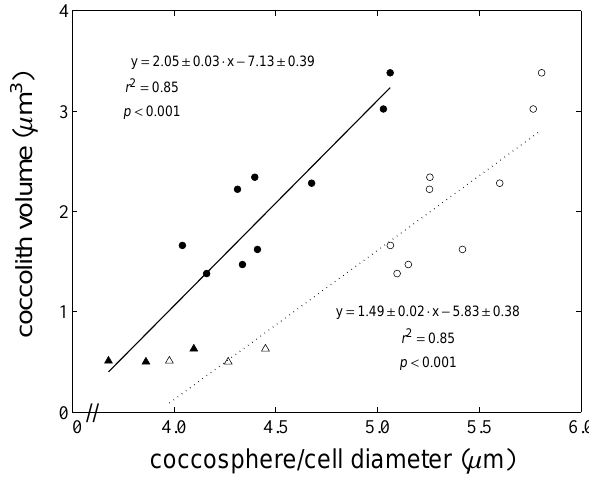
Fig. 4. Coccolith volume as a function of the cell (filled symbols) and coccosphere (open symbols) diameter. Circles and triangles indicate the batch and chemostat experiments, respectively.